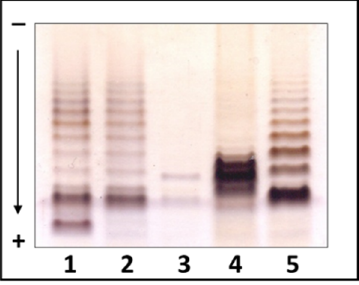
Figure 5. Edwardsiella lipopolysaccharides analyzed by tricine SDS-PAGE . E. tarda EIB202 (lane 1), E. piscicida HL9.1 (lane 2), E. ictaluri AL-15-01-CATFISH, (lane 3), E. hoshinae DSMZ 13771 T (lane 4) and E. anguillarum 205/03 (lane